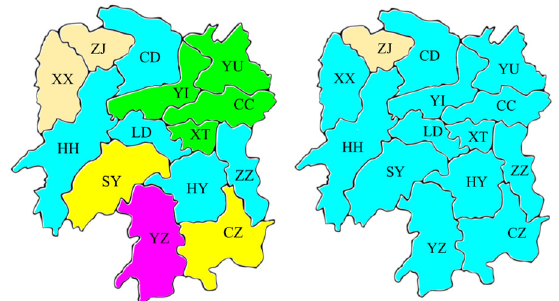
Figure 8 . Clustering of the PM 2.5 (left panel) and NO 2 (right panel) of 14 cities in Hunan